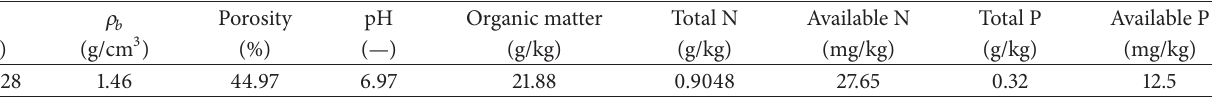
Table 1: Physical and chemical characteristics of topsoil (0–30 cm layer) in